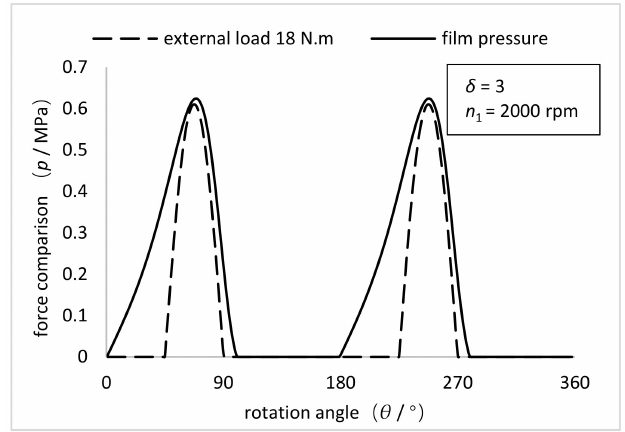
Figure 9. Comparison between the simulation results of pressure distribution of the oil film on the inner wall of the FS with the NFWG and the experimental results of external load distribution of the FS with the conventional FWG under the torque of 18 N · m ( δ = 3, n 1 = 2000 rpm).